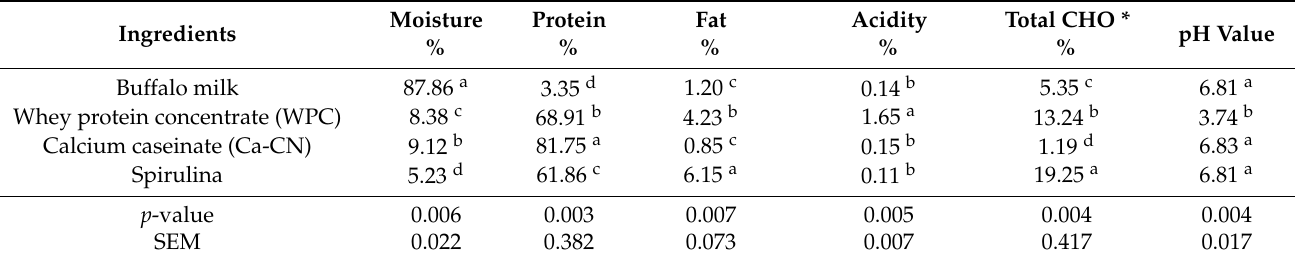
Table 2. Physicochemical properties of ingredients used in produced